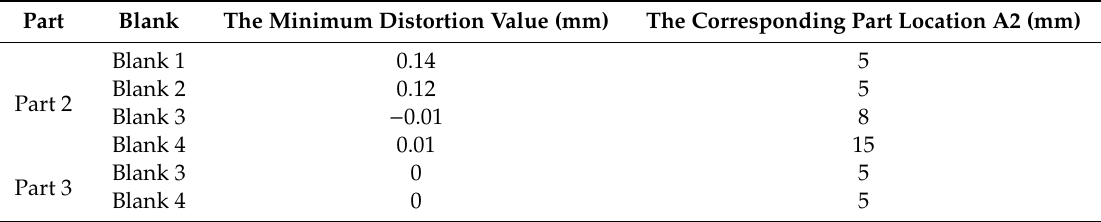
Table 3. The theoretical minimum distortion and the corresponding part